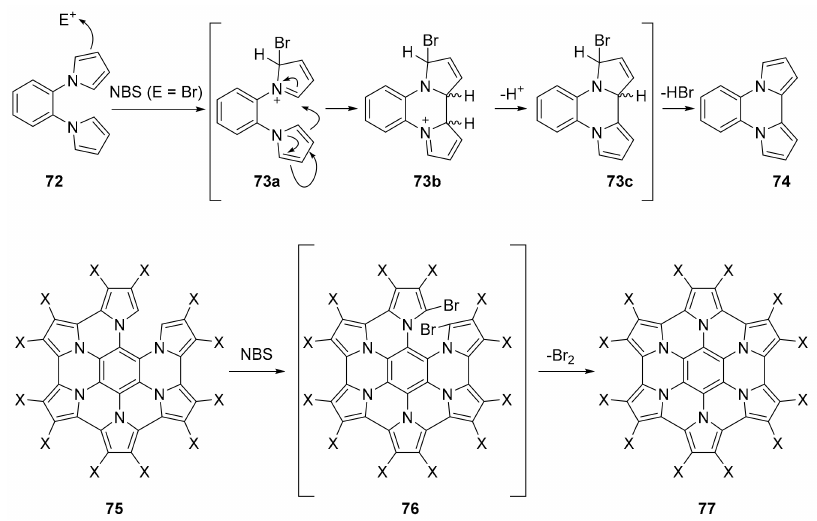
Scheme 20. Proposed mechanisms for the NBS induced